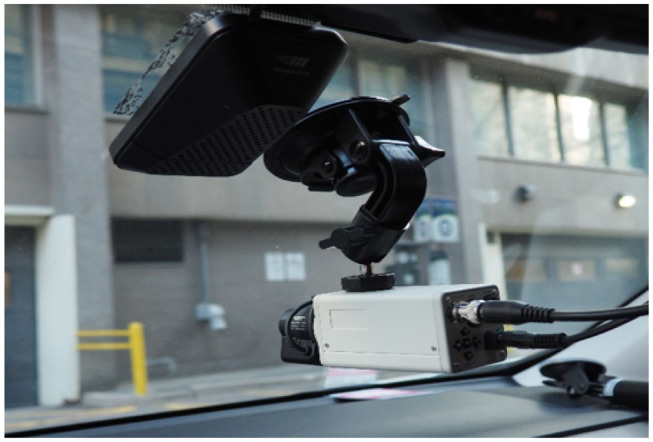
MobilEye (black unit) and front-facing camera mounted on windshield.